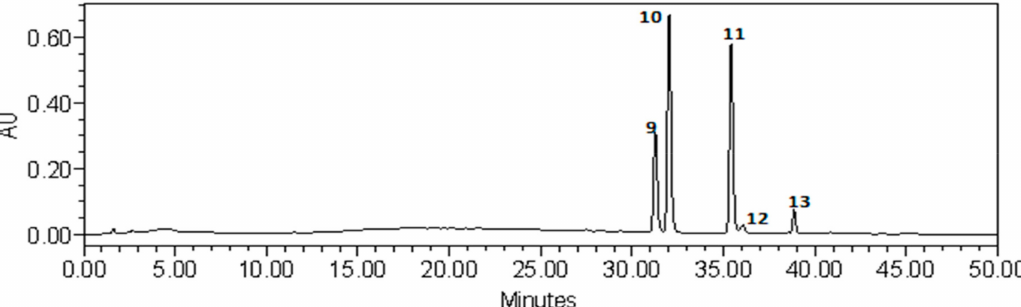
Figure 4. Chromatogram of the 70% aqueous methanol fraction extracted from placenta of control pepper